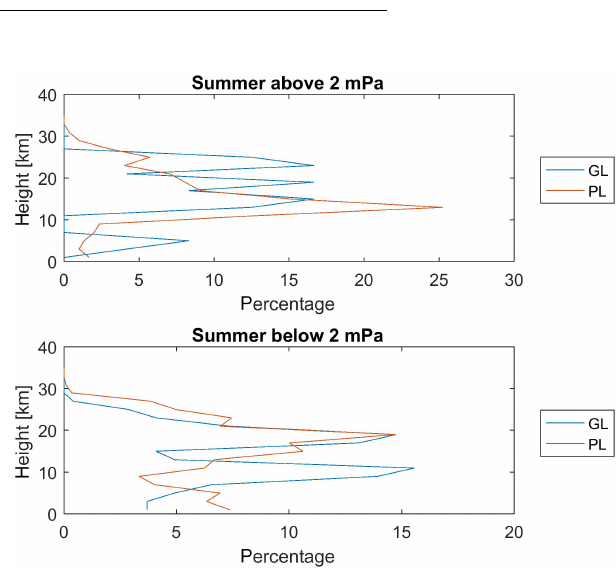
Figure 9. The same as Fig. 8 but for summer.